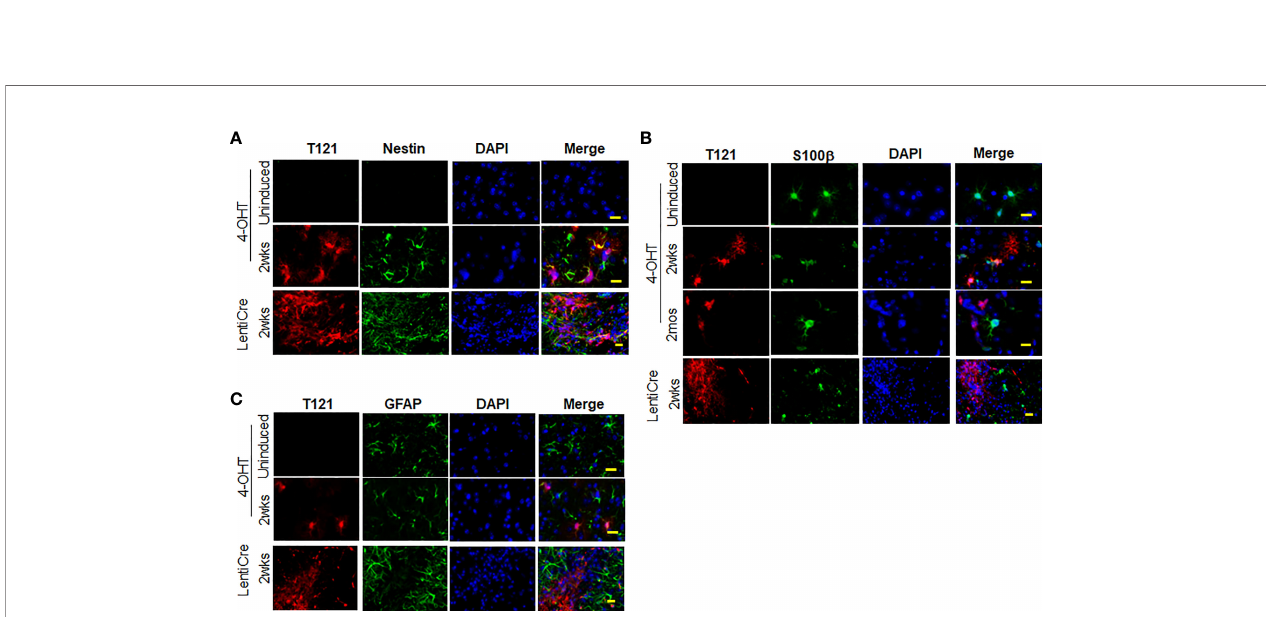
FIGURE 3 | Expression of nestin, S100 b and GFAP upon Rb-TS inactivation in GEMM. (A) Immuno fl uorescence of sagittal sections of brain denoting cortical area in uninduced, T 121 globally (IP 4OHT injection) induced 2wks post induction and focally induced using lenti virus expressing Cre recombinase (lenti-Cre) 2wks post induction. T 121 -red, nestin-green, merge and DAPI (nuclei) in blue. Scale bar indicates 20 micron. (B) Immuno fl uorescence of sagittal sections of brain denoting cortical area in uninduced, T 121 globally (IP 4OHT injection) induced 2wks and 2mos post induction and focally (LentiCre) induced 2wks post induction. T 121 -red, S100 b -green, merge and DAPI (nuclei) in blue. Scale bar indicates 20 micron. (C) Immuno fl uorescence of sagittal sections of brain denoting cortical area in uninduced, T 121 globally (4OHT) induced 2 wks post induction and focally (LentiCre) induced 2wks post induction. T 121 -red, GFAP-green, merge and DAPI (nuclei) in blue. Scale bar indicates 20 micron.